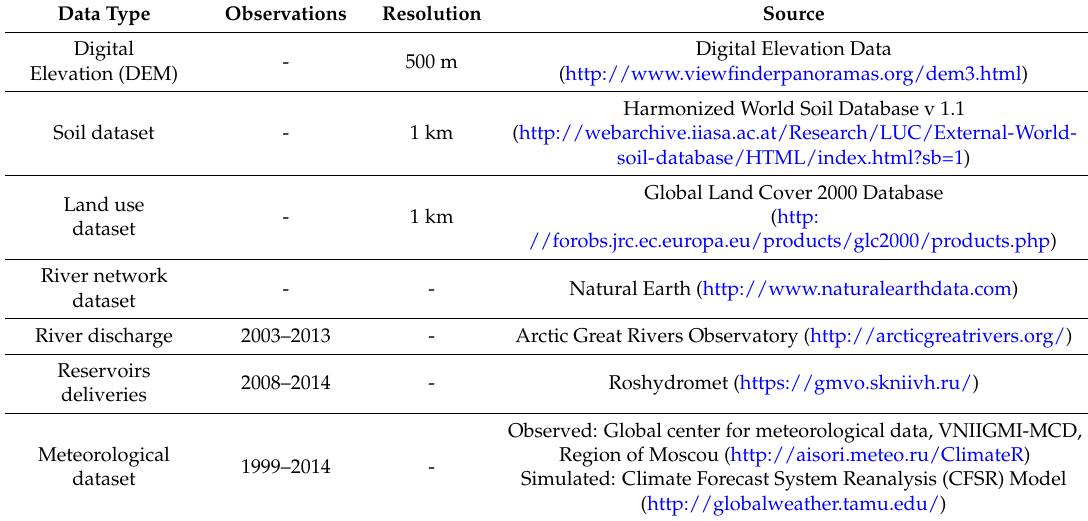
Table 3. SWAT data inputs and observations